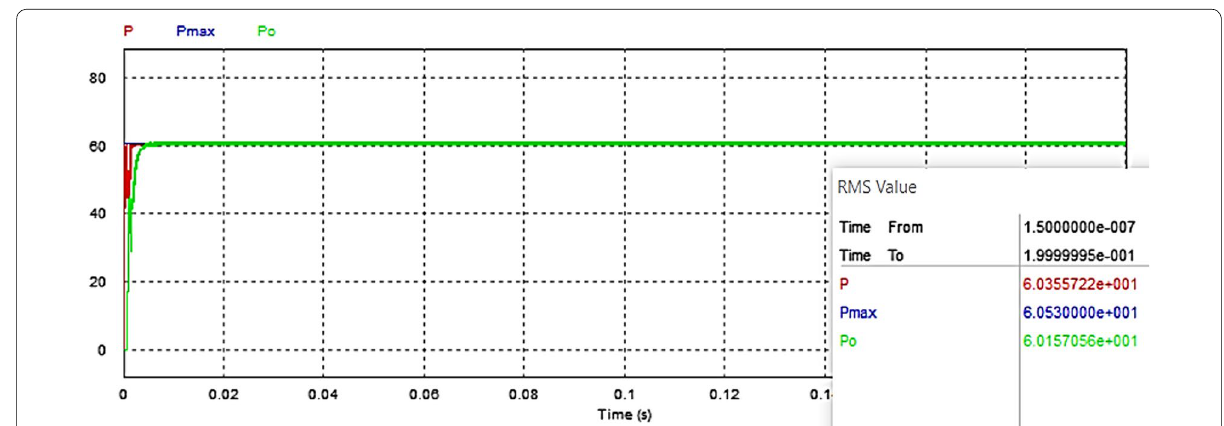
Fig. 10 Output powers for Kalman filter based MPPT under